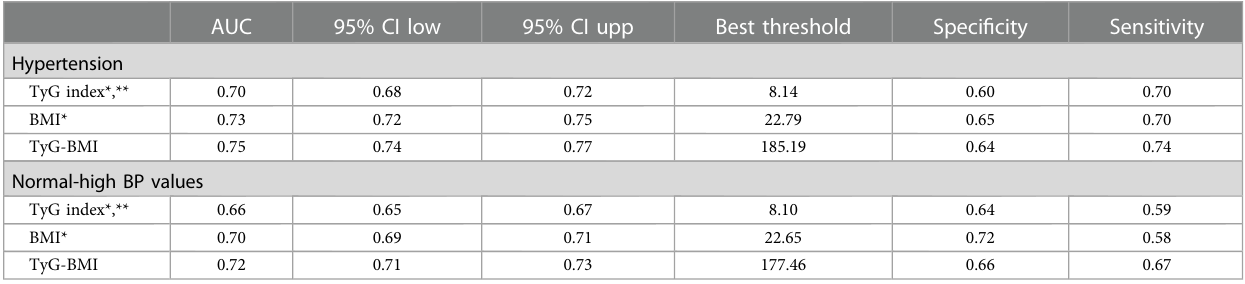
TABLE 3 Areas under the receiver operating characteristic curves for each evaluated parameters in identifying normal-high BP values and hypertension. AUC 95% CI low 95% CI upp Best threshold Speci fi